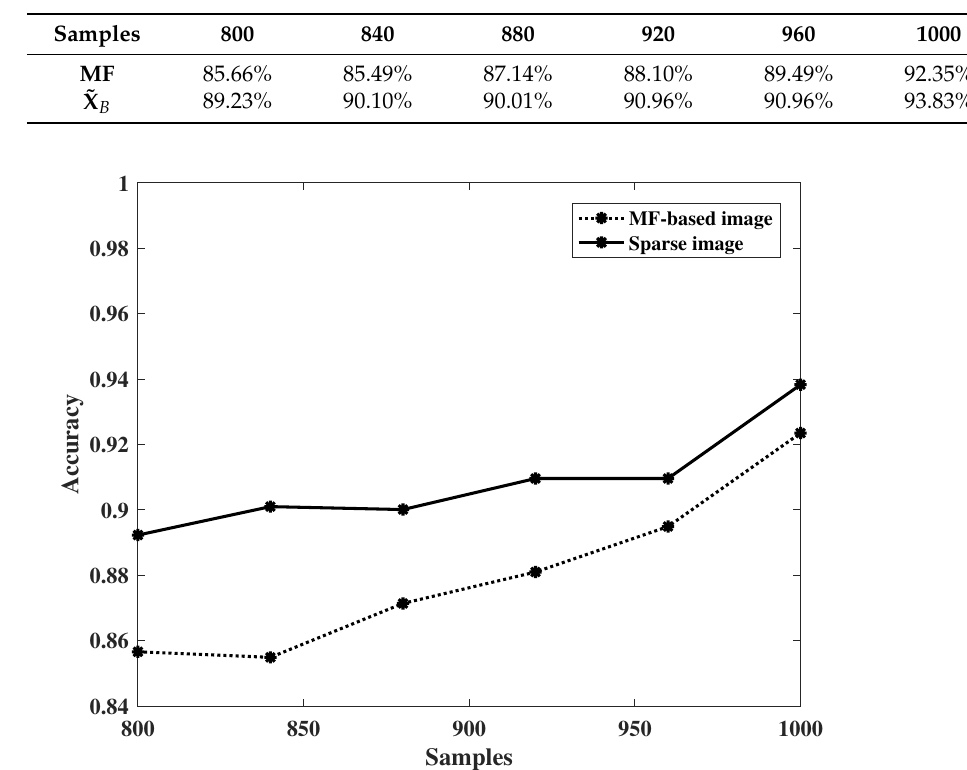
Figure 13. Experimental results based on different input datasets under EOC.